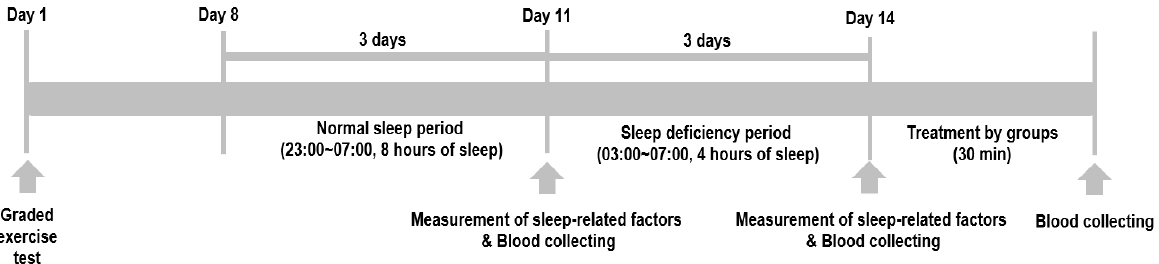
Figure 2. Experimental procedure.